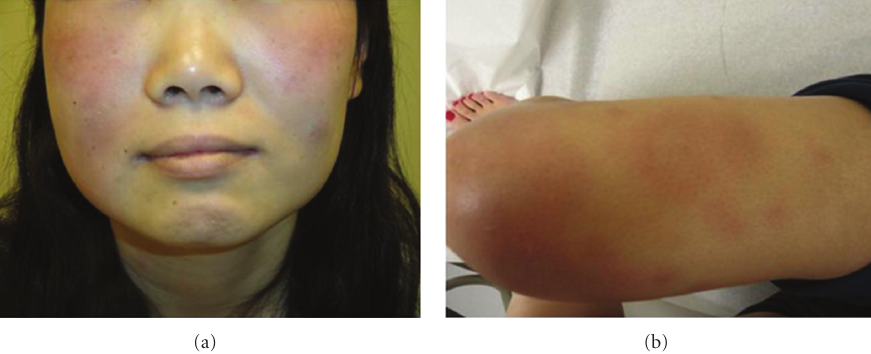
Figure 1: Multiple 2-3cm tender, erythematous, subcutaneous nodules were present over (a) the face and (b) lower